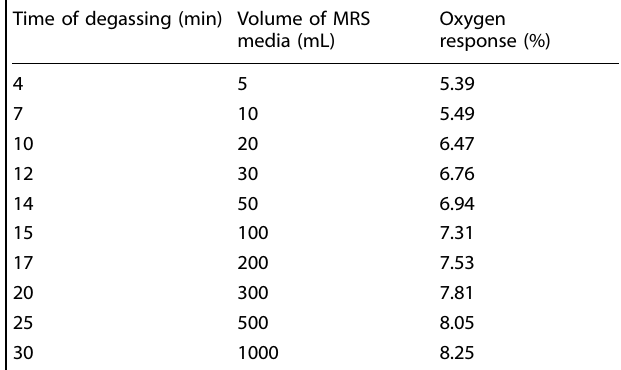
Fig. 4 Oxygen monitoring in growth media. The obtained oxygen levels are shown as response of the fi beroptic oxygen probe (%) vs. mL of MRS medium. Table 1. Oxygen values determined in degassed MRS